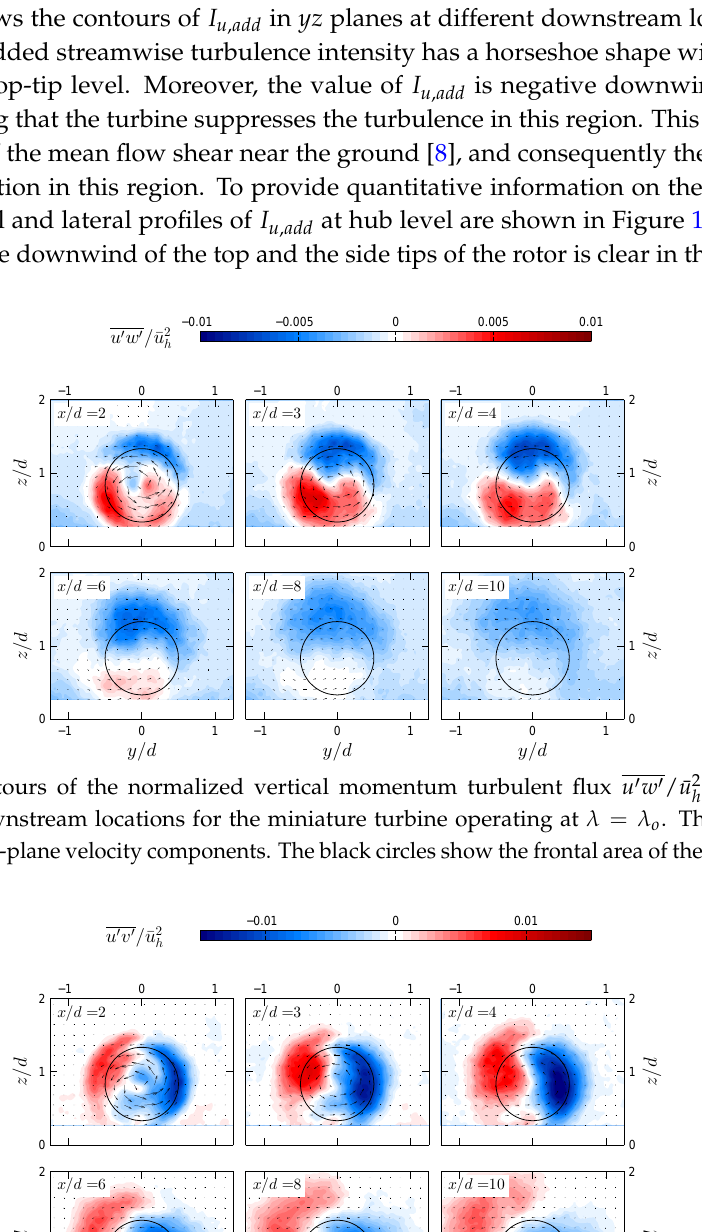
in yz planes at different h